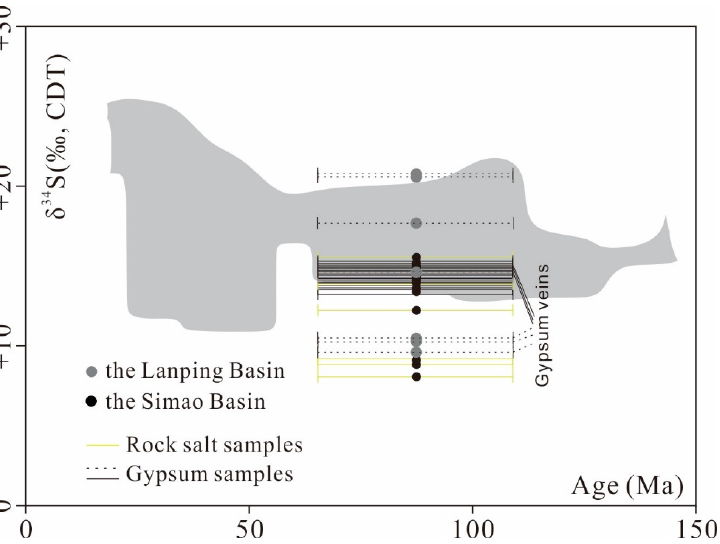
Figure 8. Comparison between δ 34 S values of sulfates in the Lanping–Simao Basin and contempo- raneous seawater (data from [21]). neous seawater (data from